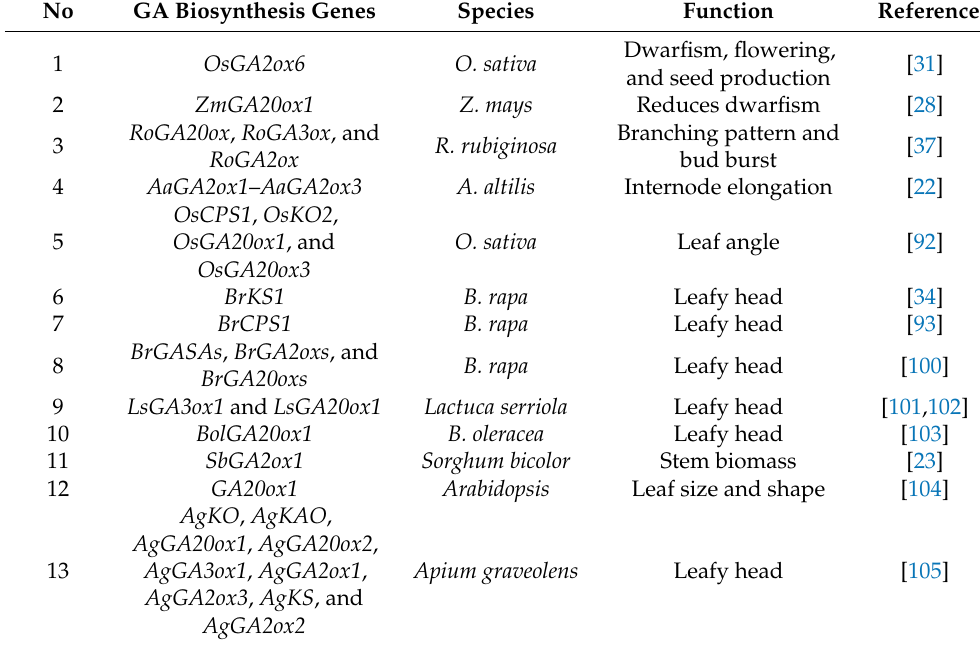
Table 1. Representative cloned genes associated with plant development related to GA